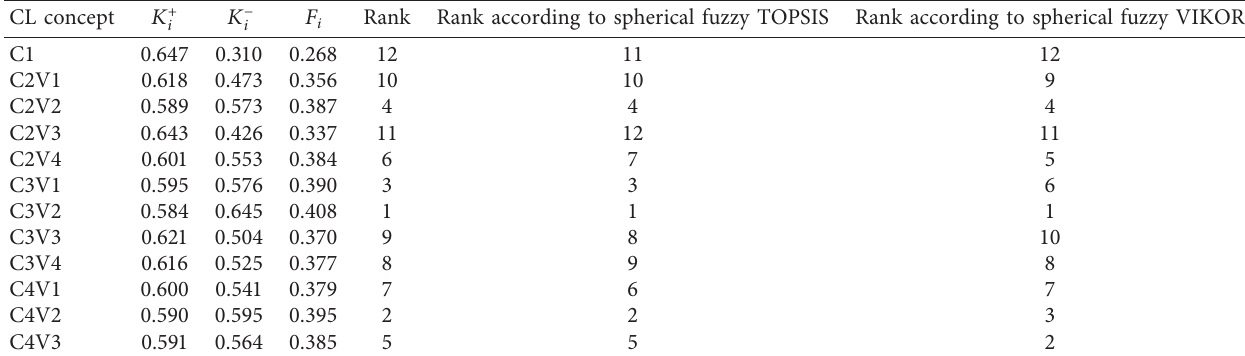
Table 5: Final drone-based CL concept scores and their ranking.